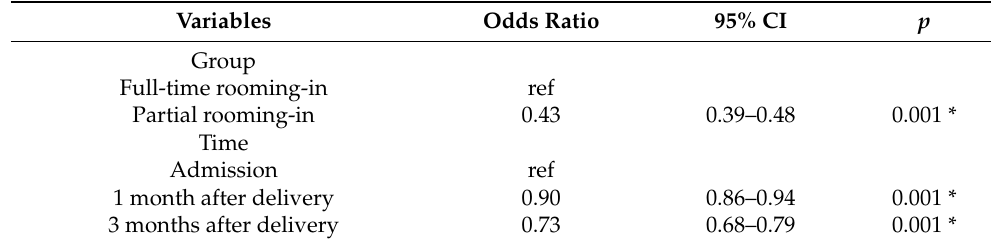
Table 2. Generalized estimating equations to analyze the associations between rooming-in types and exclusive breastfeeding ( n =